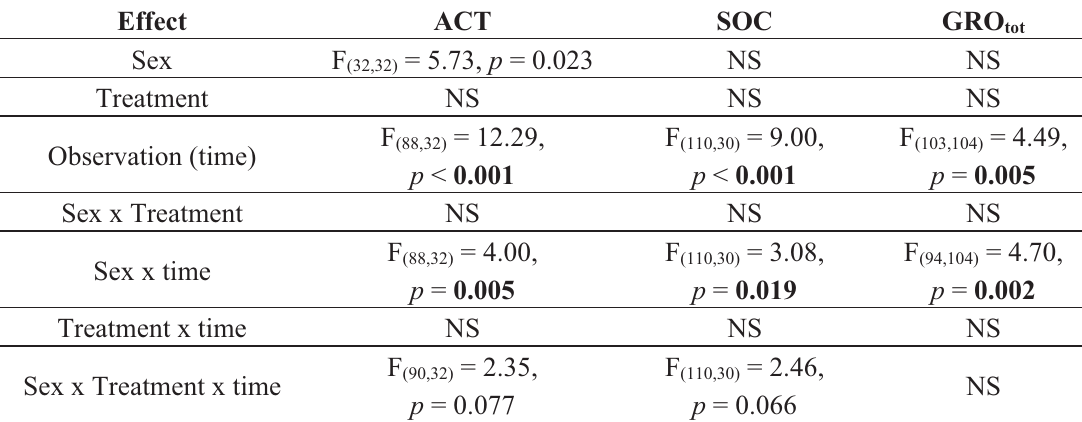
Table 2. Behavioral observations; Effects (bold p -values) and trends (italic p -values) of transfer on the behavioral categories Locomotor activity (ACT), Social behavior (SOC) and Grooming (GRO) n = eight cages.